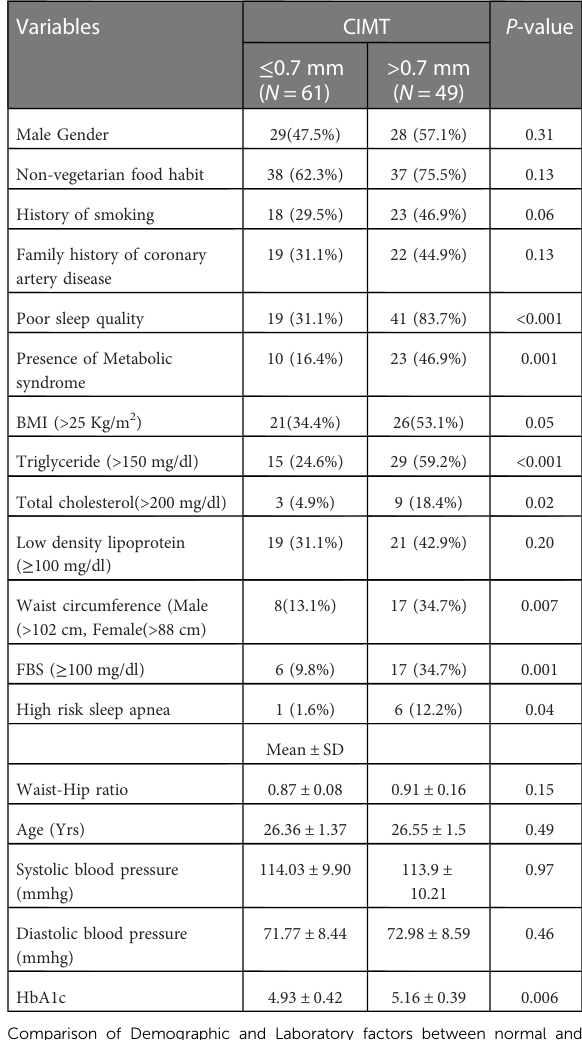
TABLE 1 Comparison of factors associated with carotid intima-media thickness.